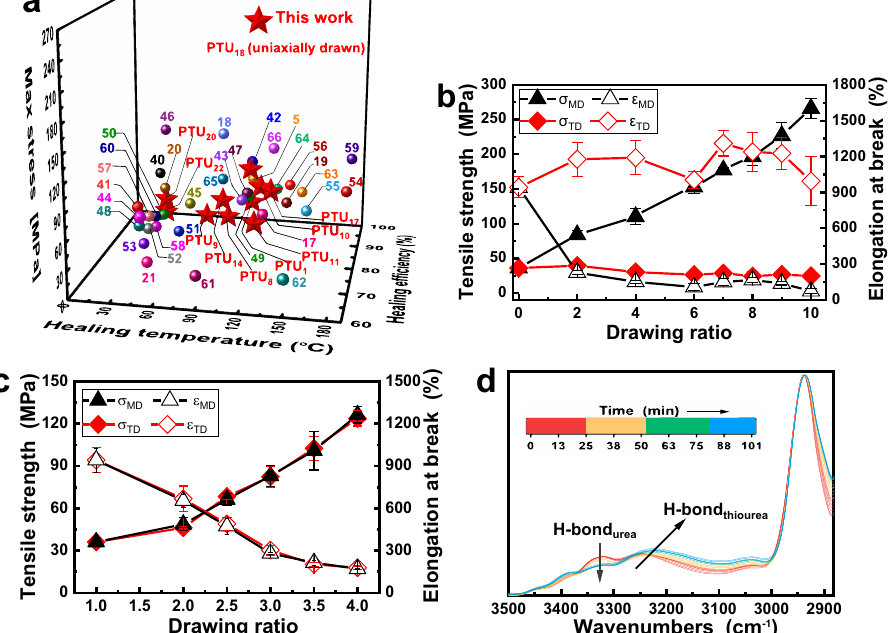
Fig. 4 Dynamicity and mechanical properties. a Relationships between tensile strength and self-healing ef fi ciency and trigger temperature of various PTUs in comparison with those of the previously reported healable polymers containing different reversible covalent/non-covalent bonds (The numbers next to symbols represent the bibliographies. Here, the strengths refer to those of the original materials. All the materials are not treated by solid-state drawing, except PTU 18 that is stretched to the maximum stroke (1 mm min − 1 , 60 °C) and kept for 100 min). b , c Tensile strengths and elongation at break of ( b ) uniaxially and ( c ) biaxially drawn PTU 18 as a function of drawing ratio (The error bars show the standard deviations from at least fi ve tests). d Real-time FTIR spectra of the -NH- peaks of stretched PTU 18